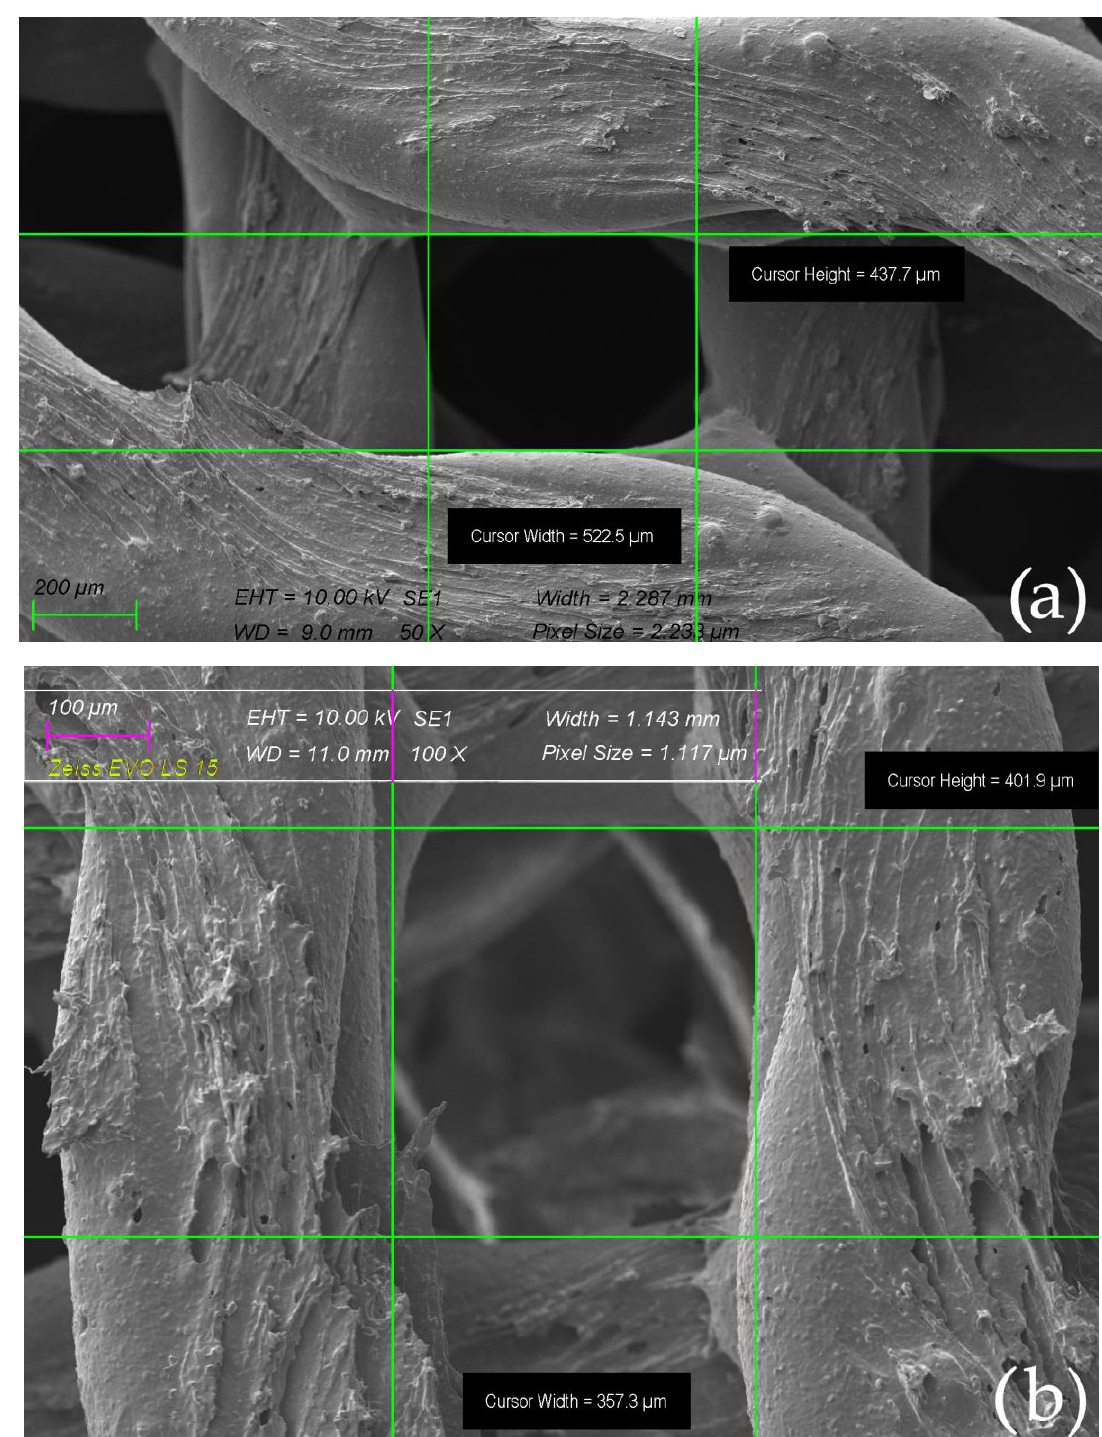
Figure 7. The morphology of the scaffolds observed by SEM before biocolonization with MSCs: ( a ) gyroid scaffold measured before sintering; ( b ) gyroid scaffold measured after sintering in 1400 °C.